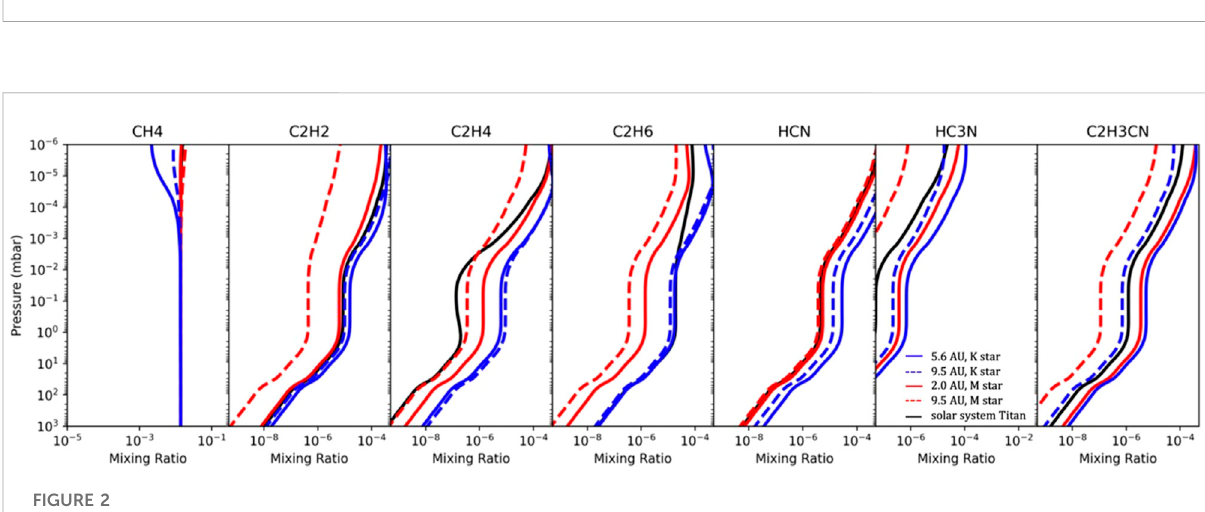
Response to stellar type and irradiation; all cases are at a Titan-like temperature and N 2 -dominated atmosphere. Black line: Sun-like star at 9.55 AU; solid red line: M-Dwarf star at 2.0 AU; dashed red line: M-Dwarf star at 9.5 AU; solid blue line: K star at 5.6 AU; dashed blue line: K star at 9.5 AU. Note that the total irradiation at 2.0 AU from an M-Dwarf host star and 5.6 AU from a K star are both comparable to the total irradiation a world experiences at 9.55 AU from a Sun-like star. From left to right, the panels show CH 4 , C 2 H 2 , C 2 H 4 , C 2 H 6 , HCN, HC 3 N, and C 2 H 3